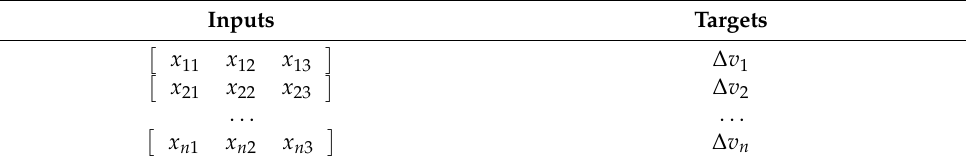
Table 2. Training data